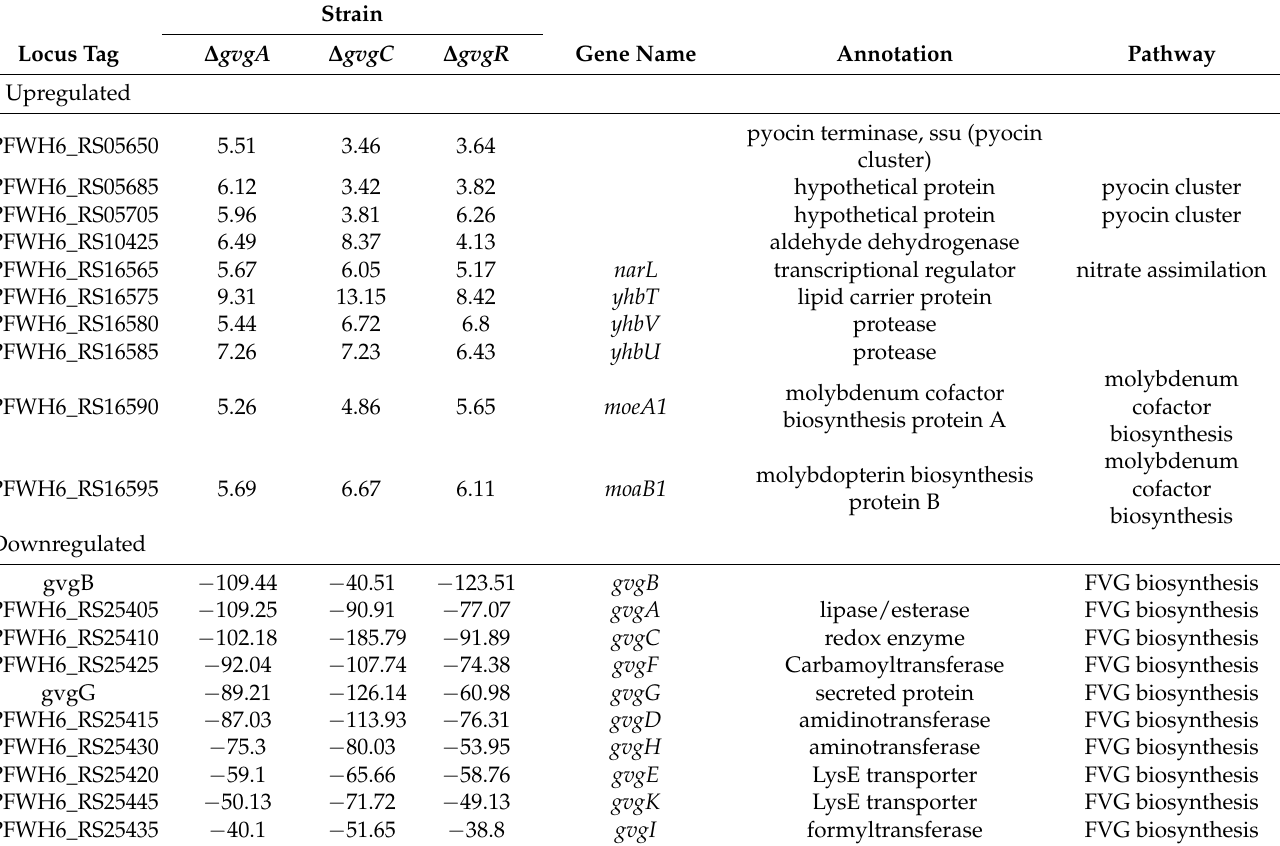
Table 2. Top ten similarly regulated genes in gvg cluster mutants compared to wild type WH6.